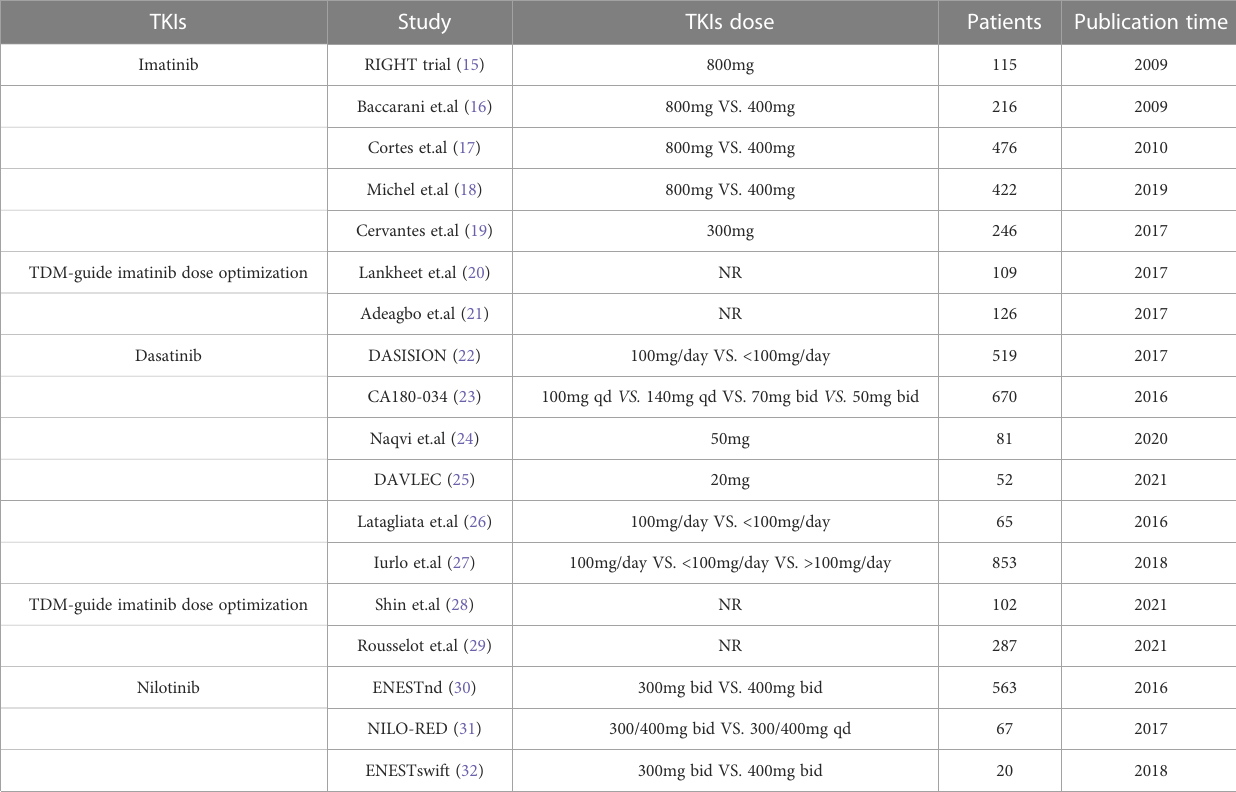
TKIs Study TKIs